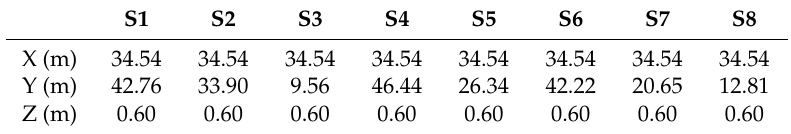
Table 10. The coordinates of gas sensor in optimal deployment scheme based on WGAC algorithm.